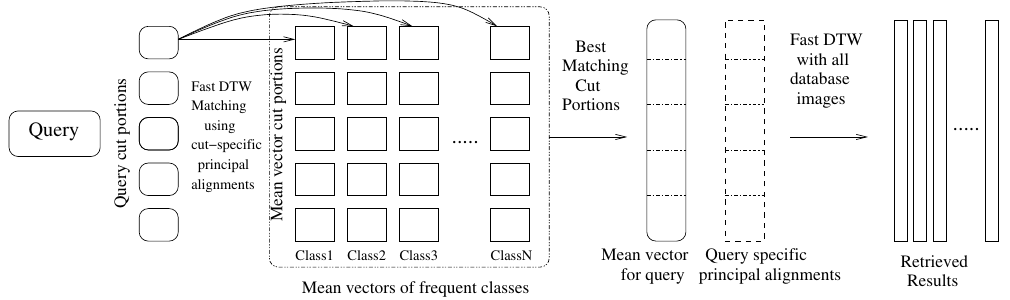
Figure 3. Overall Scheme for NN DQC. In an offline phase, the mean vectors for the frequent word classes are computed and their cut-specific principal alignments are computed. To process a query word image, it is divided into cut portions and Fast DTW matching is used to get the best matching cut-portions from the frequent class mean vectors with the cut-portions of the query image. These best matching cut-portions are used to construct the mean vector for the query class and the query specific principal alignments. Fast DTW [20] matching between the query image and the database images is done using the query specific principal alignments.